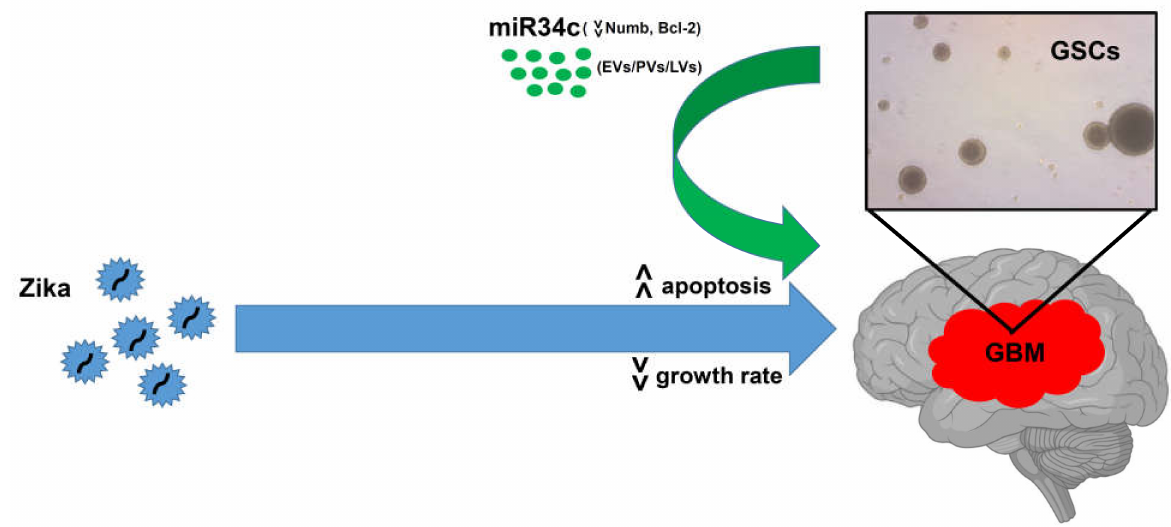
Figure 1. ZIKV-based therapeutic approaches. ZIKV can be directly used against GBM for its specific action against GSCs (blue arrow). ZIKV induces apoptosis and reduces growth rate in GSCs. Additional studies strongly suggest that miR34c is responsible for ZIKV-mediated effects in GSCs, thus supporting alternative therapeutic approaches based on miR34c overexpression by means of extracellular vesicles (EVs), pseudoviruses (PVs) or lentivirus (LVs) (green